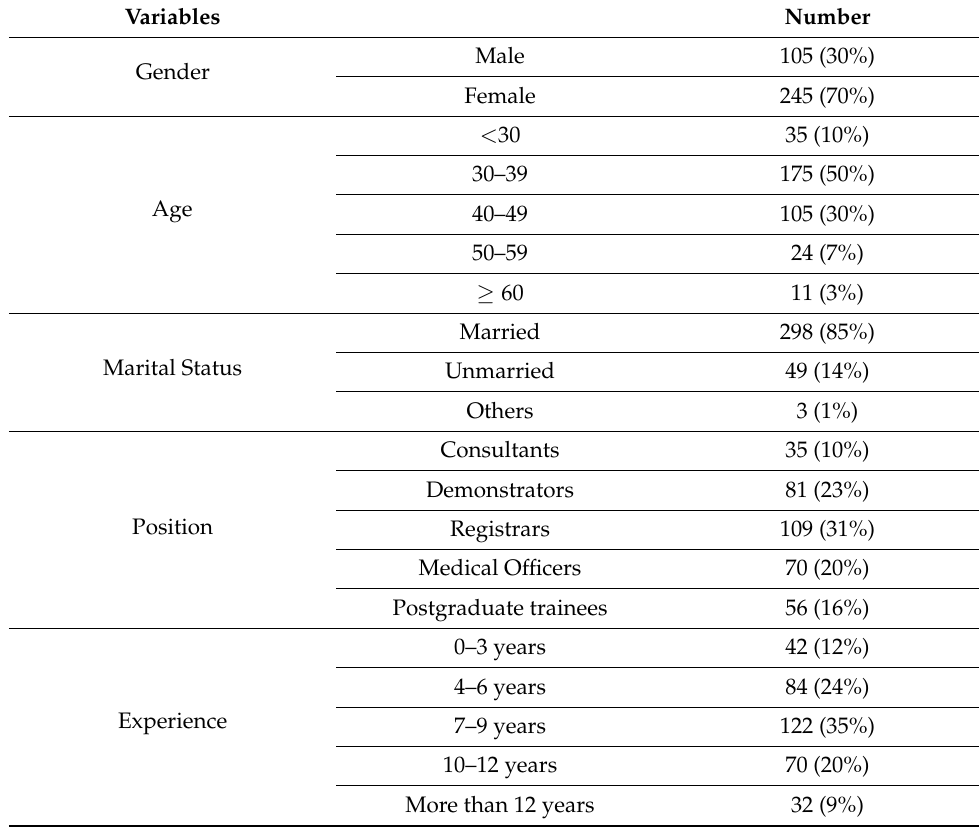
Table 1. Demographic variables.